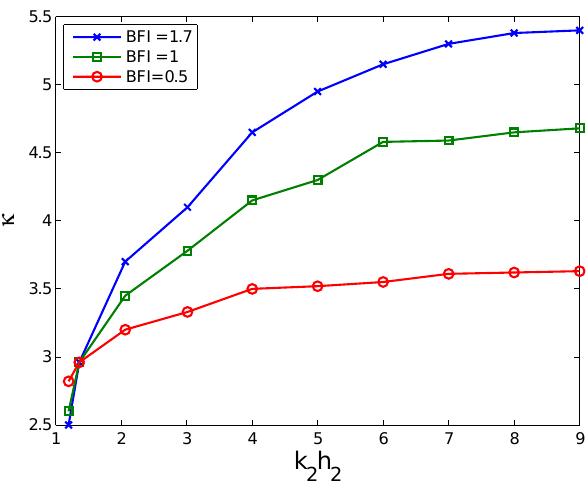
Fig. 12. Kurtosis variation with respect to k 2 h 2 after the slope for different initial